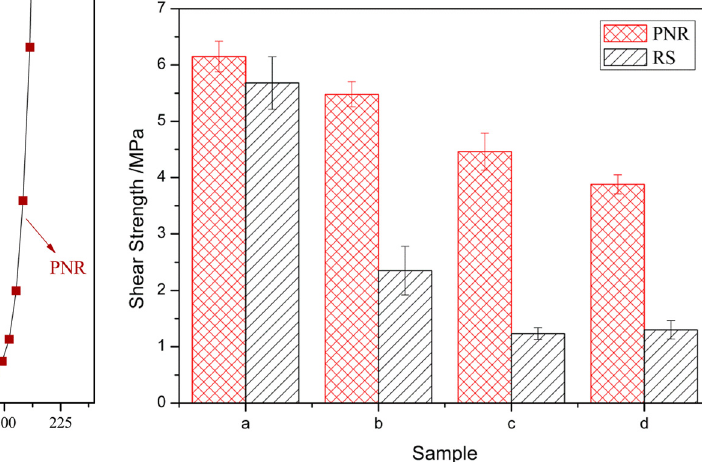
Figure 11: Complex viscosity variation with temperature for the PNR and RS.